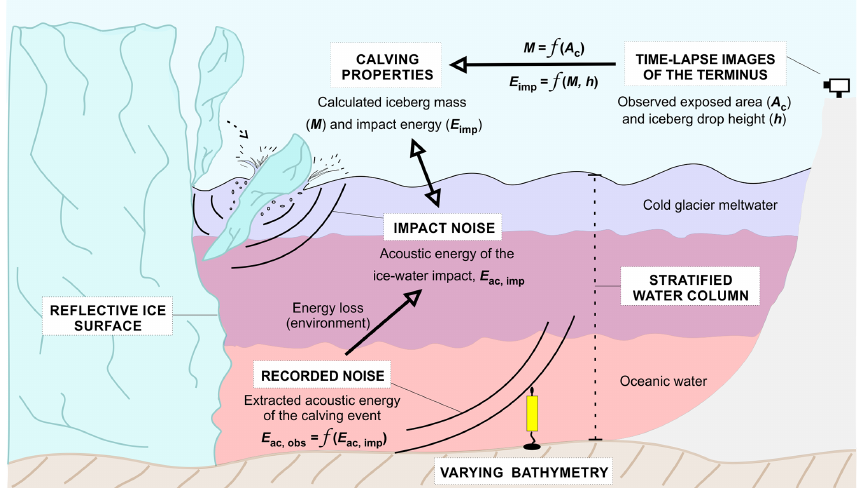
Figure 4. A scheme illustrating the application of passive underwater acoustics to measure iceberg calving fluxes. The study consists of (1) time-lapse observation of individual calving events; (2) estimation of ice mass loss and block–water impact energy based on the captured images; (3) recordings of underwater noise at a safe distance from the glacier terminus; and (4) calculation of impact noise energy for given thermohaline conditions, bathymetry along the transmission path and contribution of noise reflected from the ice